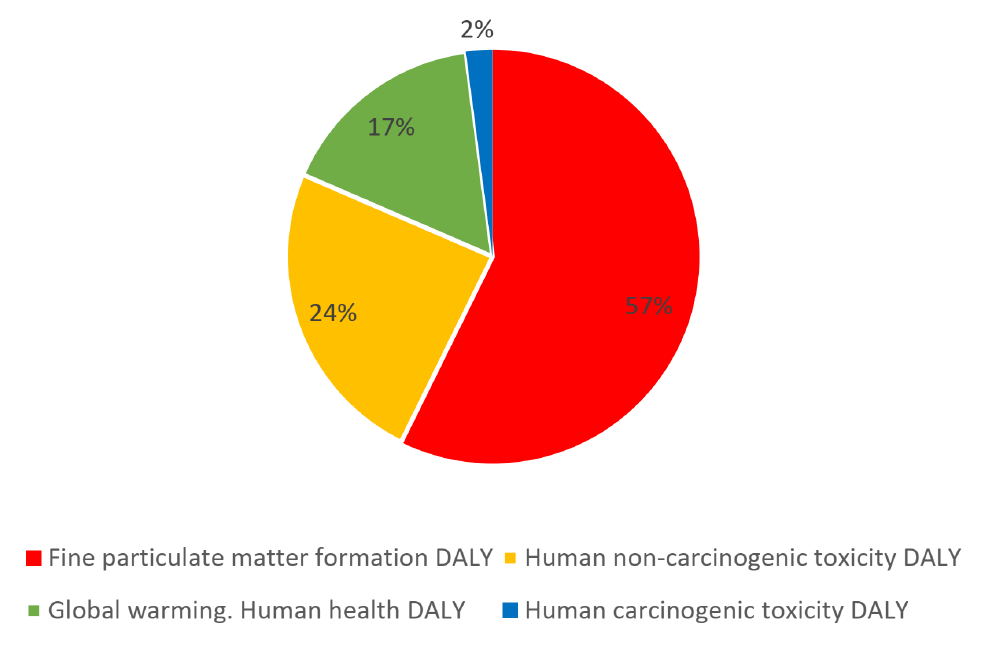
Figure 4. Contribution to Human Health of different impacts. Results are obtained with ReCiPe 2016—Endpoint (H)